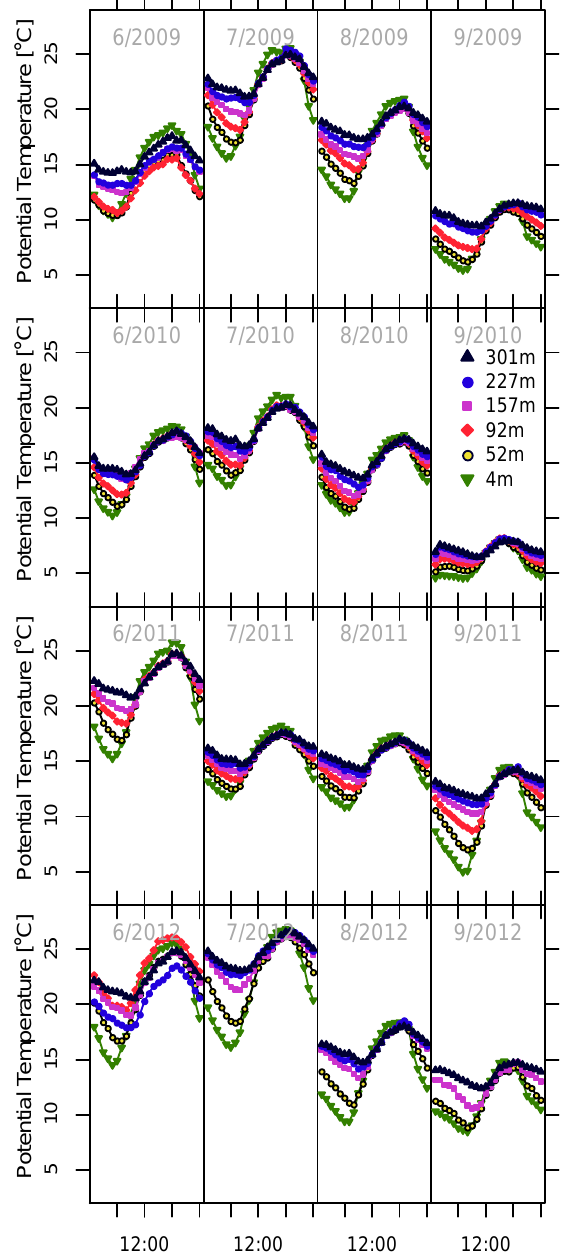
Fig. 5. Diurnal cycle of potential temperature, averaged for individ- ual months and years.